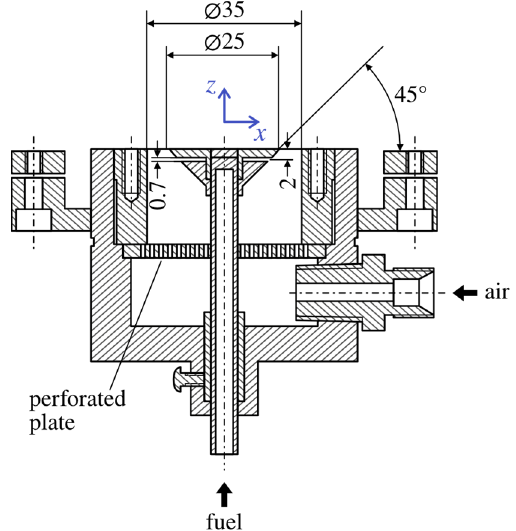
Figure 1. Axial cross-section of the diffusion flame burner [20].